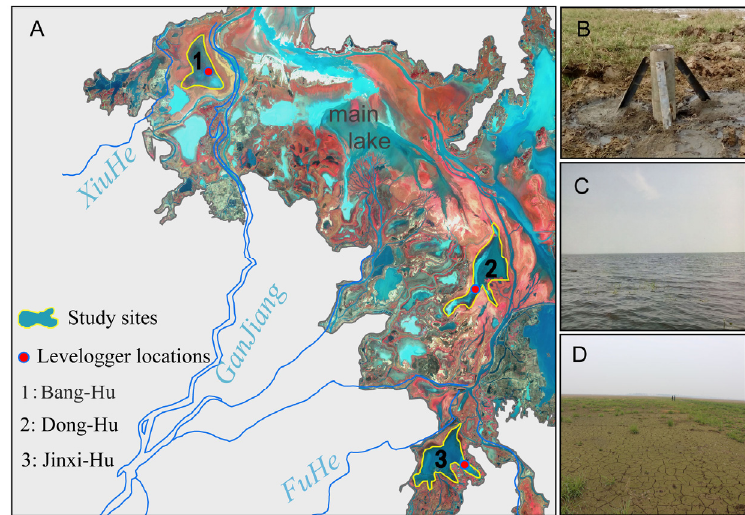
Figure 2. The study sites and context. Sub-figure ( A ): yellow outline shows study sites, and locations of water level loggers are shown as red dots. Sub-figure ( B ): the water level logger was anchored in place with steel fence posts, with the steel cable running along the lake bed in a plastic pipe. Sub- figure ( C ): Bang-Hu during high water level conditions, 2 February 2015. Sub-figure ( D ): Bang-Hu during low water level conditions, 18 May 2015.